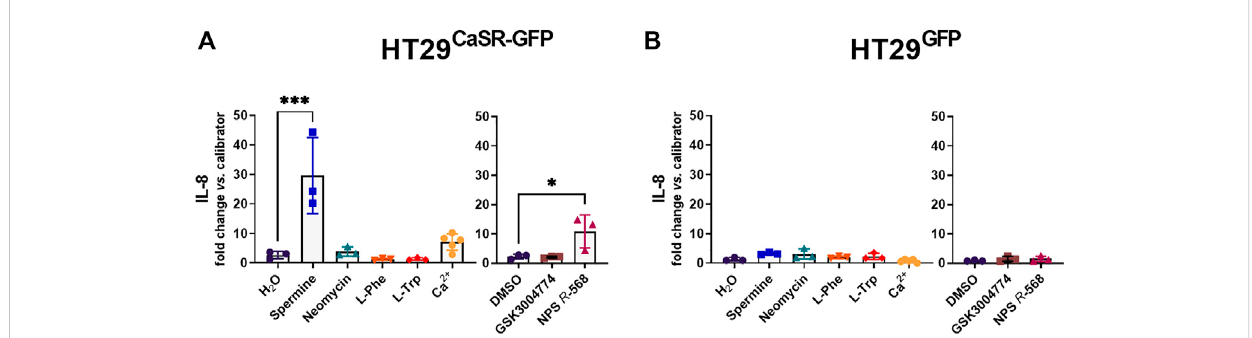
FIGURE 1 Induction of an in fl ammatory response in HT29 cells via the CaSR is ligand dependent. Relative gene expression of IL-8 in (A) HT29 CaSR − GFP and (B) HT29 GFP cellsafter 4 htreatment